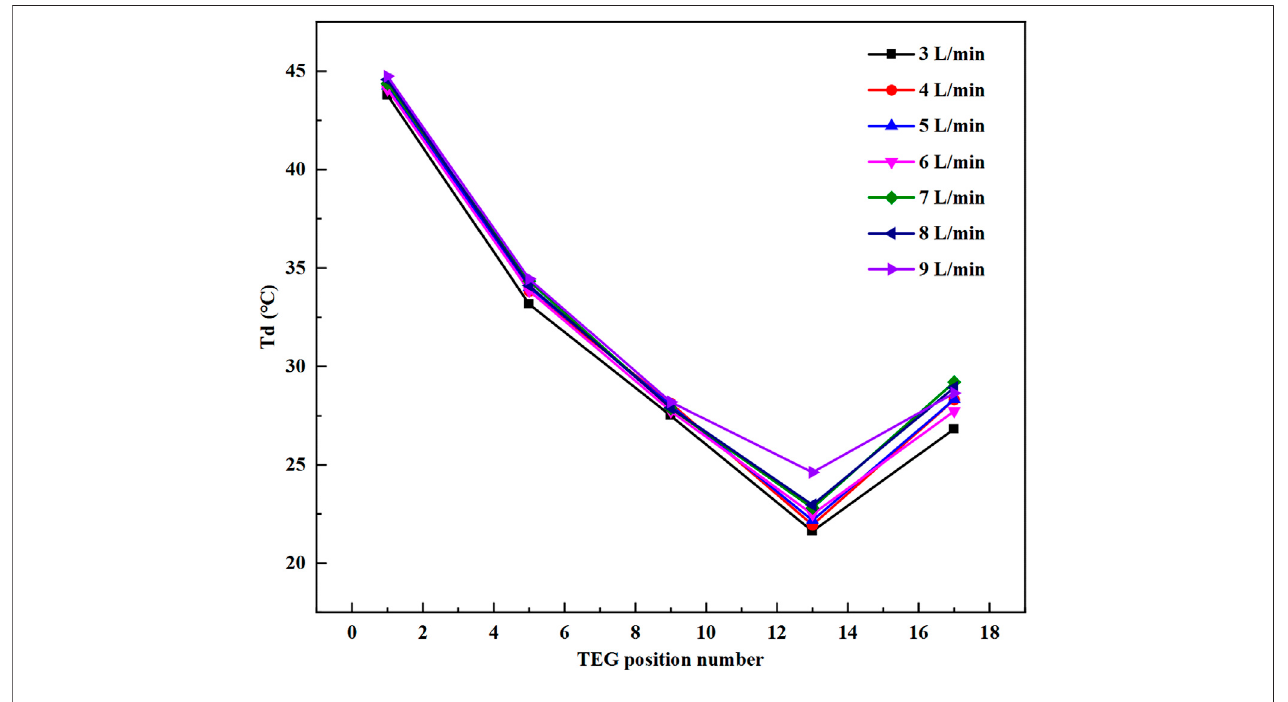
FIGURE 13 | Td curves in different water fl ows.